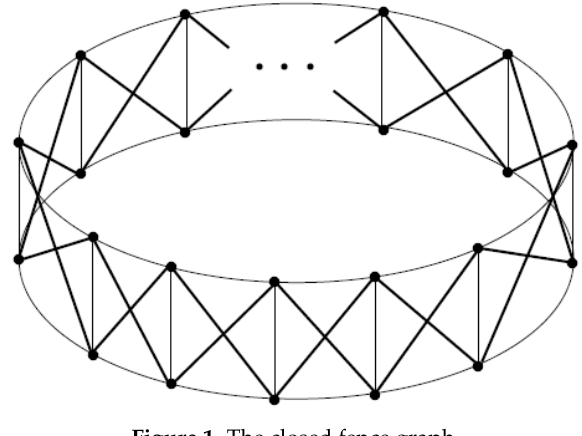
Figure 1. The closed fence graph.